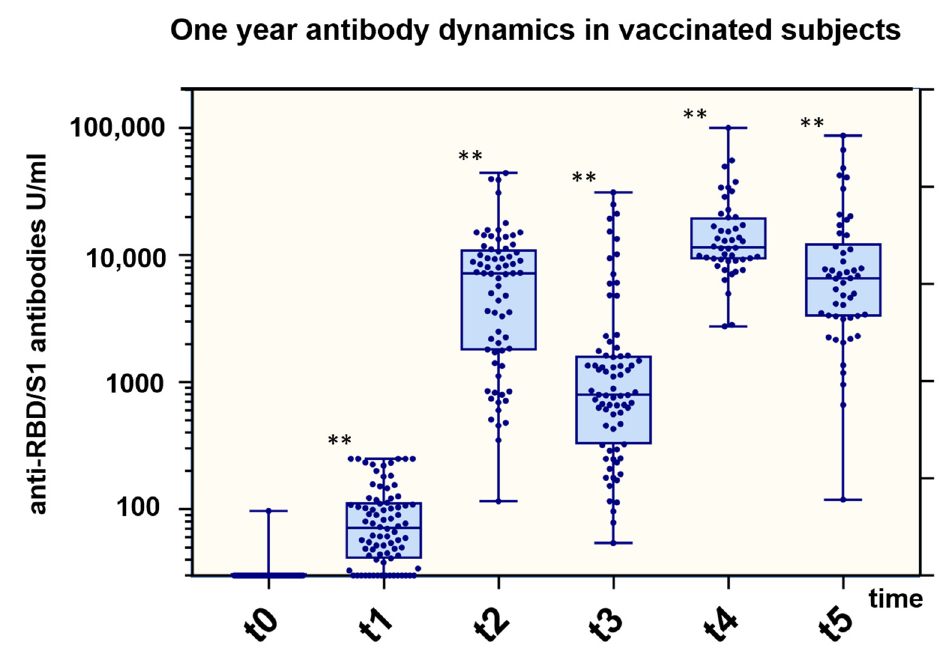
Figure 4. Total anti-RBD/S1 Ig titer related to vaccination dose. Boxplots for anti-RBD/S1 (U/mL; y -axis) at different time points (t 0 : date of vaccination; t 1 : 2 months after first vaccination; t 2 : 1–2 months after second vaccination; t 3 : 5–6 months after second vaccination; t 4 : 1–2 months after third vaccination; t 5 : 5–6 months after third vaccination ( x -axis) for 100 participants (at time of study inclusion). In plots, interquartile ranges are shown in boxes with a line representing the median and whiskers representing the minimum and maximum data values. Dots indicate individual values. Antibody titers were compared to previous time points by the Kruskal–Wallis rank sum test. p -values < 0.05 were considered to be significant; ** p -values < 0.001. Table 2. SARS-CoV-2 antibodies.